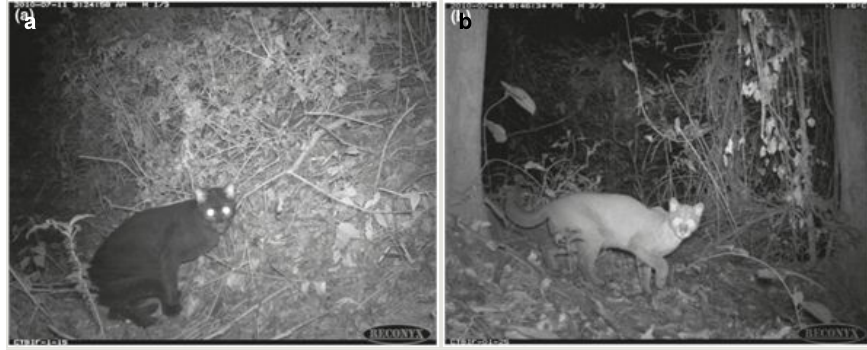
Figure 13. Camera traps document species occurrence. African Golden Cat (Mammalia: Carnivora: Felidae: Caracal aurata , formerly called Profelis aurata ) in Bwindi Impenetrable National Park, Uganda. From Mugerwa et al. (2012). a : Dark color morph. b : Light color morph.